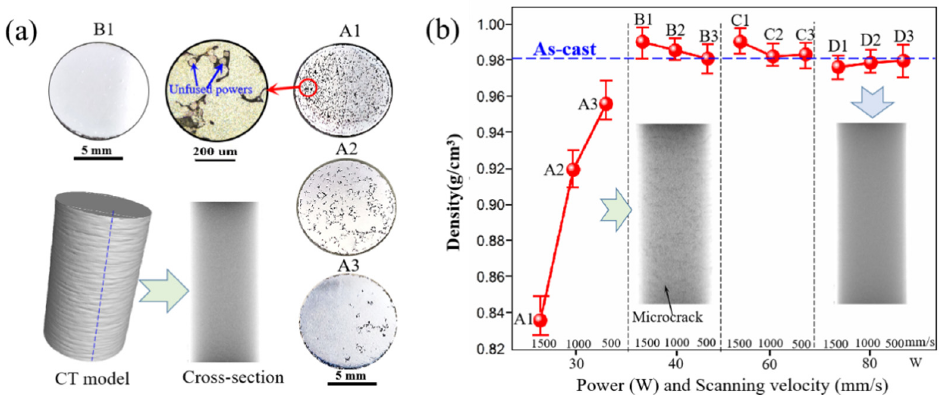
Figure 3. The porosity and density of LBPBF SnBi alloy specimen: ( a ) defects observed by optical microscopy and CT, ( b ) densities variation with the laser power and scanning velocity.